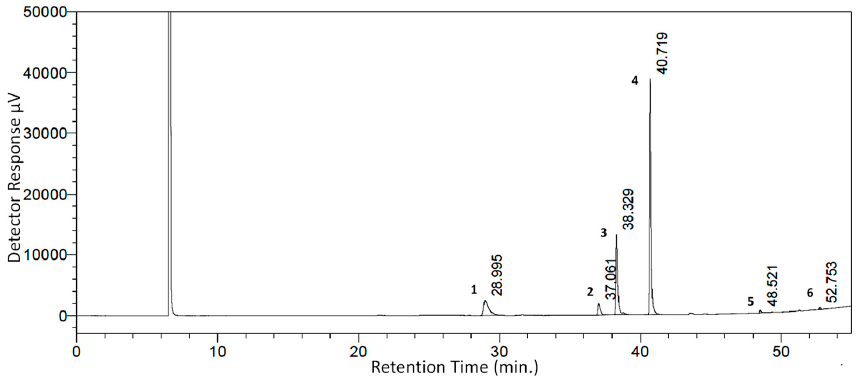
Figure 2. GC-FID chromatogram of WSSO: Fatty acid peaks were identified in WSSO based on different retention times. The % contents were quantified using a reference standard kit, and are listed in Table 1, as per peak numbers. Highest detector response was observed and quantified for peak 4 (linoleic acid, 54.15%), followed by peak 3 (oleic acid, 23.16%). Table 1. Identification of major phyto-constituents in WSSO by gas chromatography-flame ionized detector (GC-FID). Peak No.